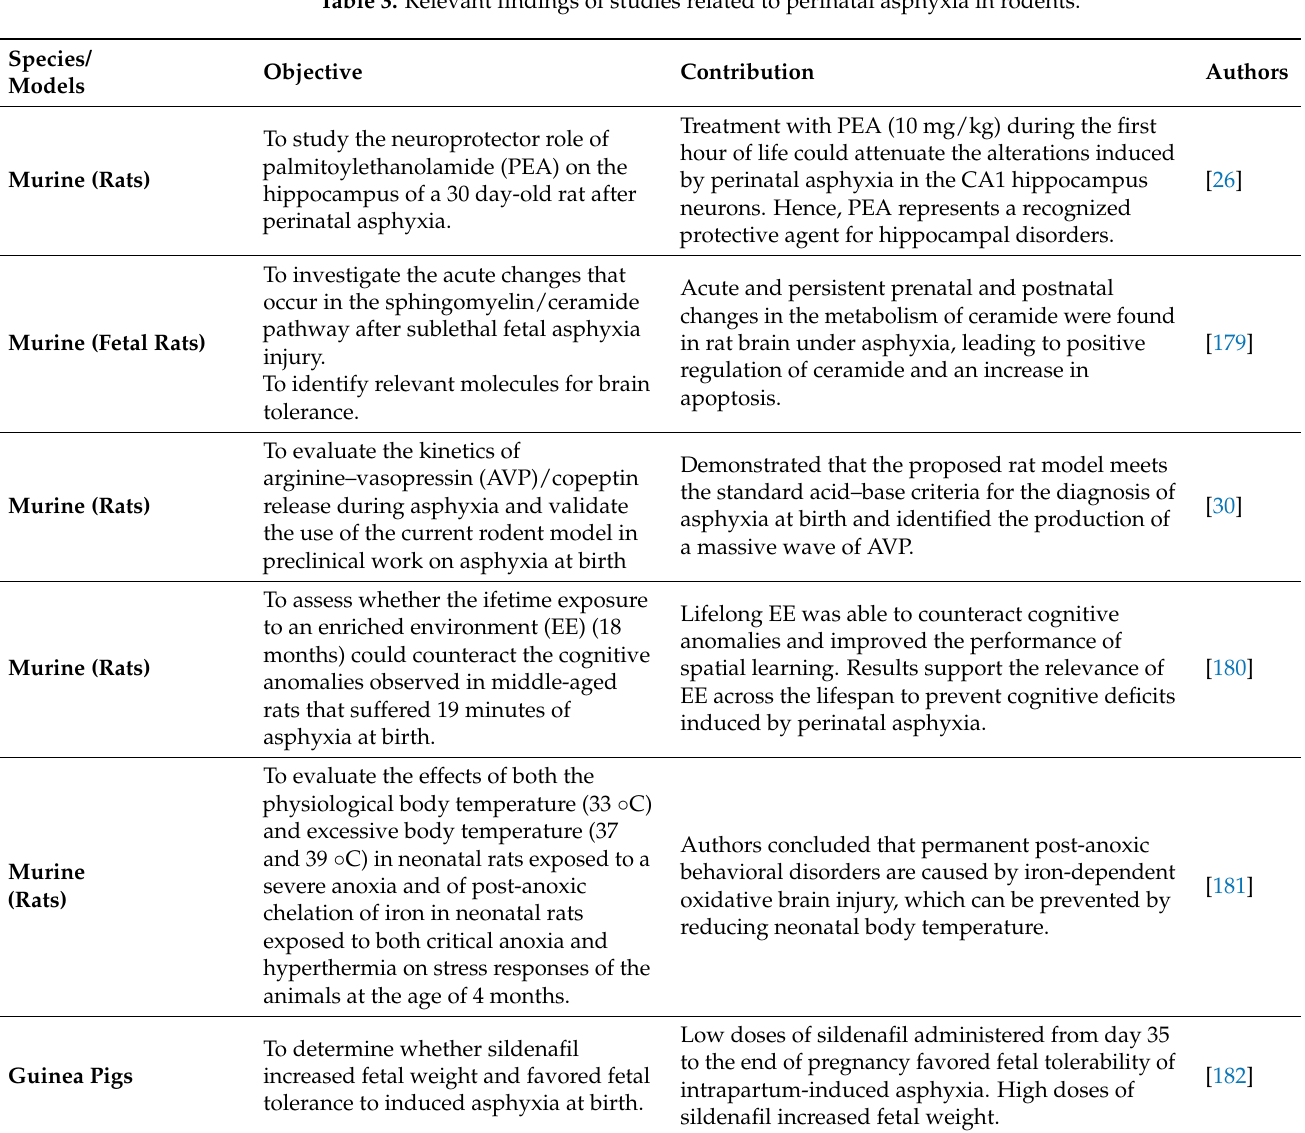
Table 3. Relevant findings of studies related to perinatal asphyxia in